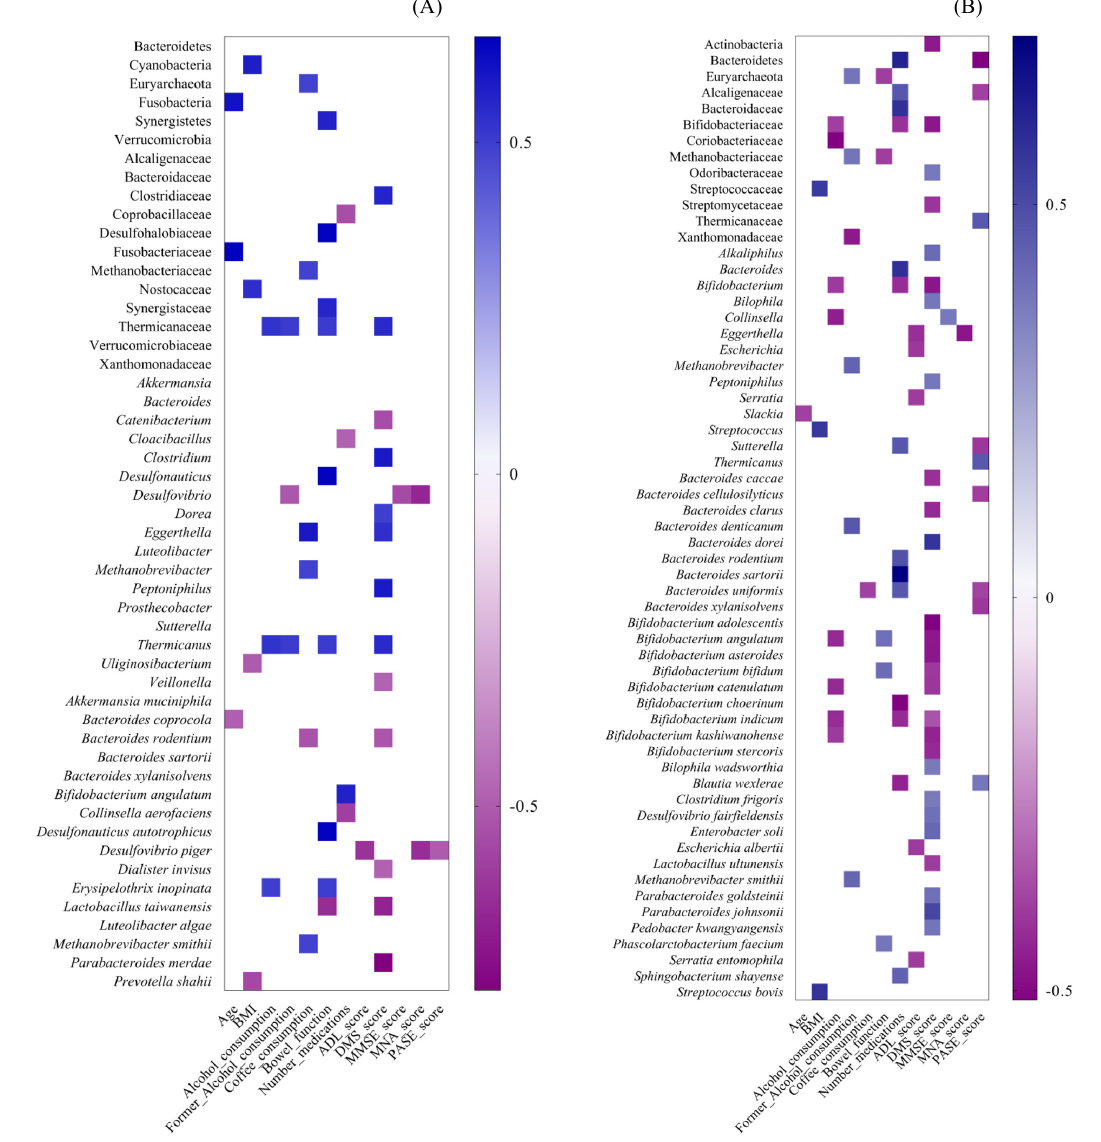
Figure 3. Spearman correlation analysis between GM alterations and clinical variables in CENT and NON. Heatmaps were generated in GraphPad Prism v.7.0d. A correlation heatmap was used to represent significant statistical correlation values (Rho) between intestinal microbiota taxa signif- icantly associated with CENT ( A ), NON ( B ) and clinical features. In the heatmap, violet squares indicate significant negative correlations (Rho < 0.0, p ≤ 0.05) and blue squares indicate significant positive correlations (Rho > 0.0, p ≤ 0.05). Only p ≤ 0.05 are shown. BMI = Body Mass Index, ADL = Activities of Daily Living, DMS = Mediterranean Diet score, MMSE = Mini Mental State Evaluation, MNA = Mini Nutritional Assessment, PASE = Physical Activity Scale for the